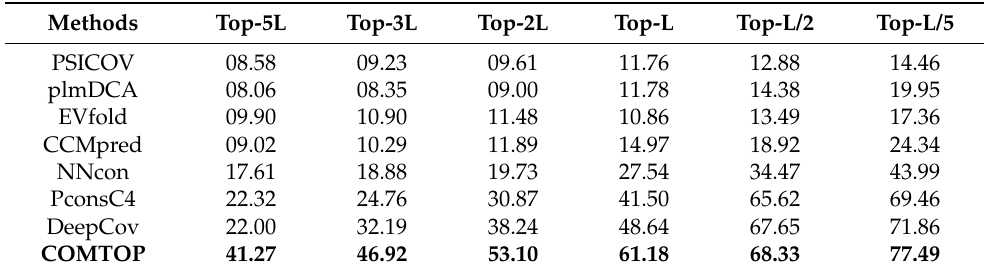
Table 6. The prediction accuracy of COMTOP with seven individual methods on CASP14 target domains.